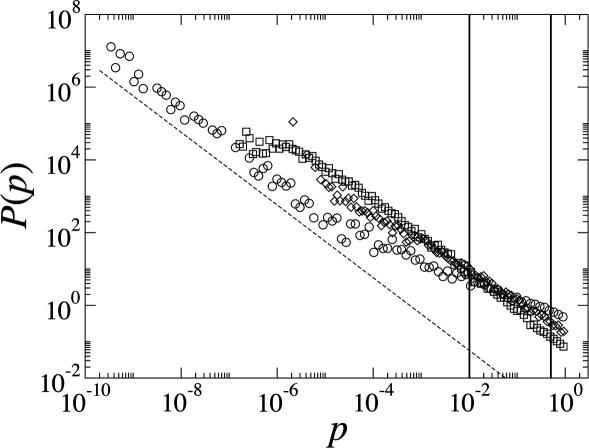
Normalized Distributions of p-Values Relative to the Cyclic Spectral Component for All Genes from Three Different Elutriation ExperimentsRustici et al. [6] (diamonds), Peng et al. [7] (squares), and Oliva et al. [8] (circles). The dashed line is an inverse power law with exponent −1. The p-values have been computed by reshuffling each signal 1010 times. 5% and 1% confidence levels are emphasized in the plot.